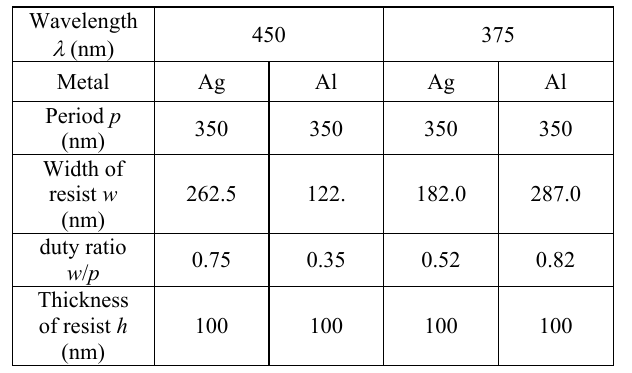
Table 1. Parameter of wire grid structures.